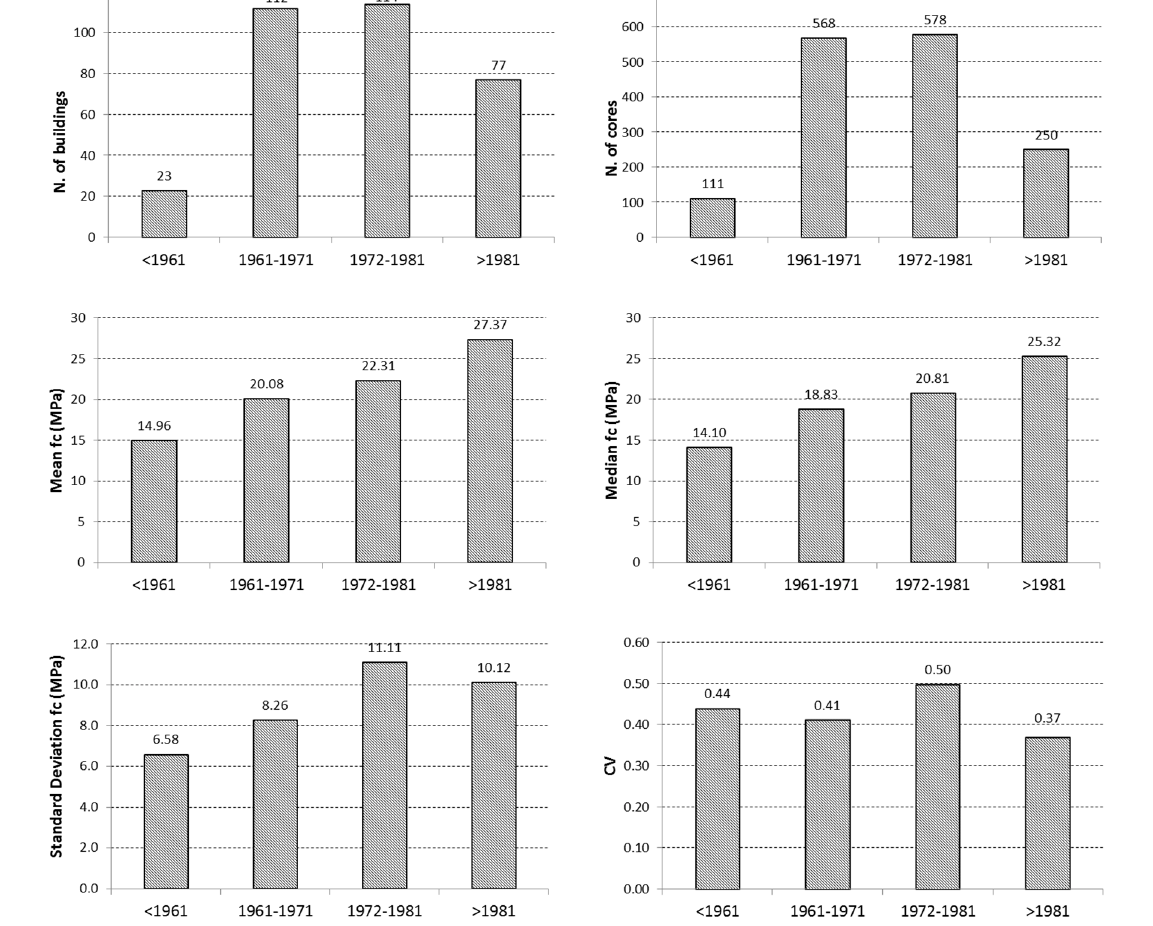
Figure 1. Distribution of the main statistical data related to the core strength values as a function of the construction period. construction